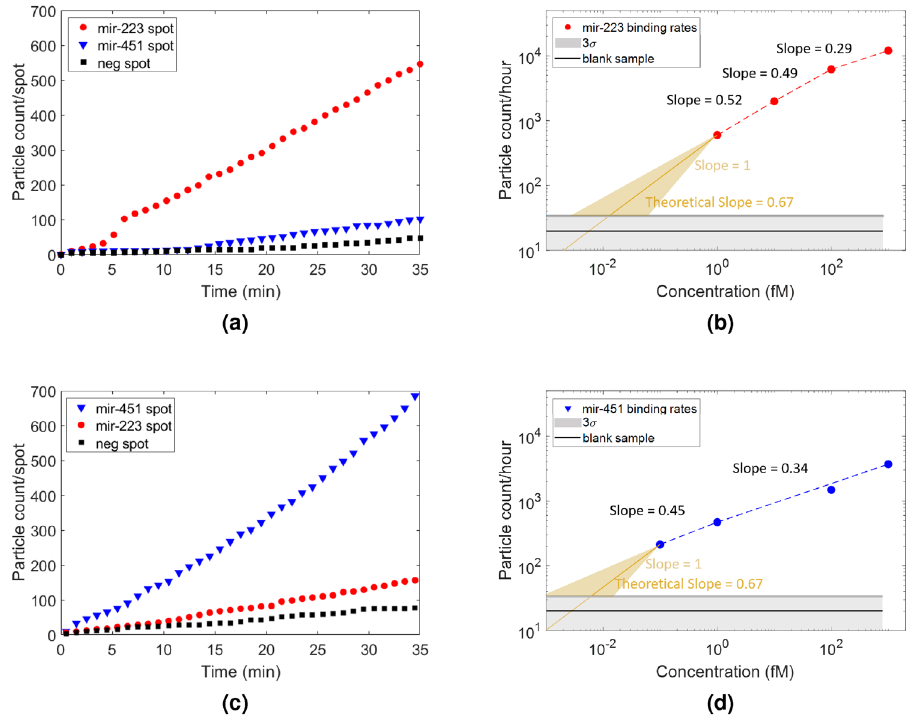
Figure 4. Cumulative number of binding events on each spot type throughout the homogeneous incubation with 10 fM miR-223 target complex and 100 fM miR-451 target complex ( a , c ). Binding rates throughout the homogeneous assay incubation with respect to target concentration ( b , d